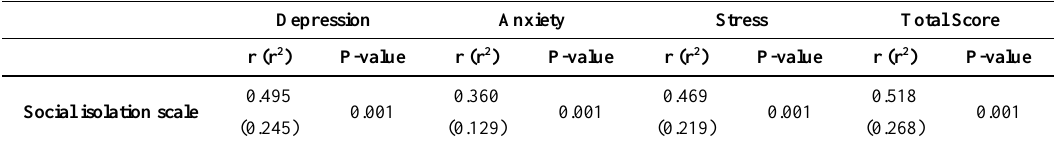
Table 5. Correlation between depression, anxiety and stress with social